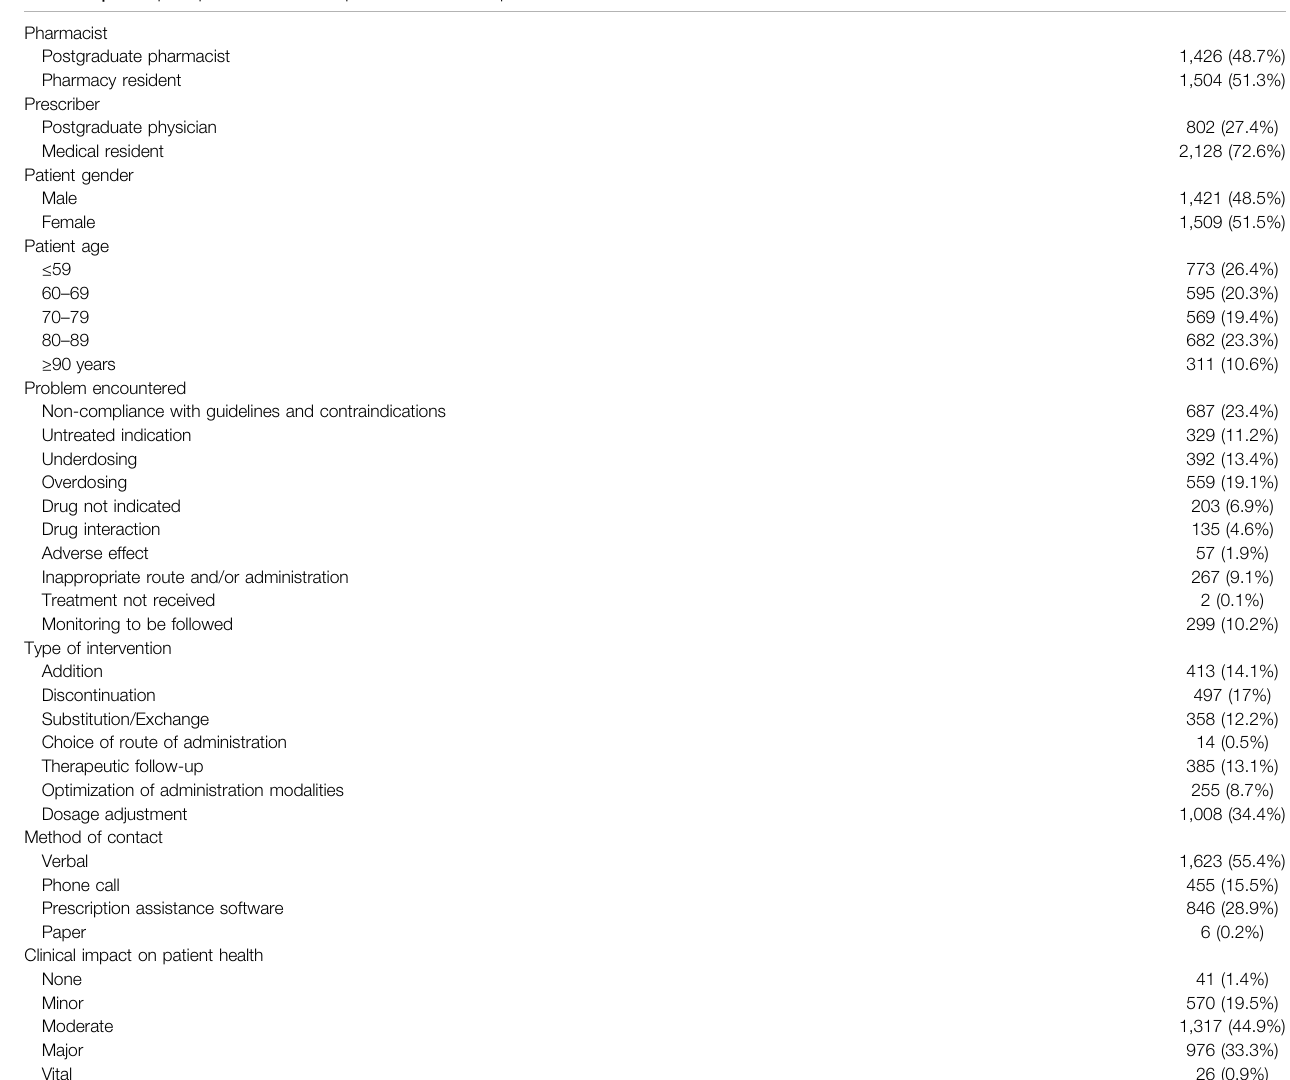
TABLE 1 | Descriptive presentation of PIs performed with acceptance status